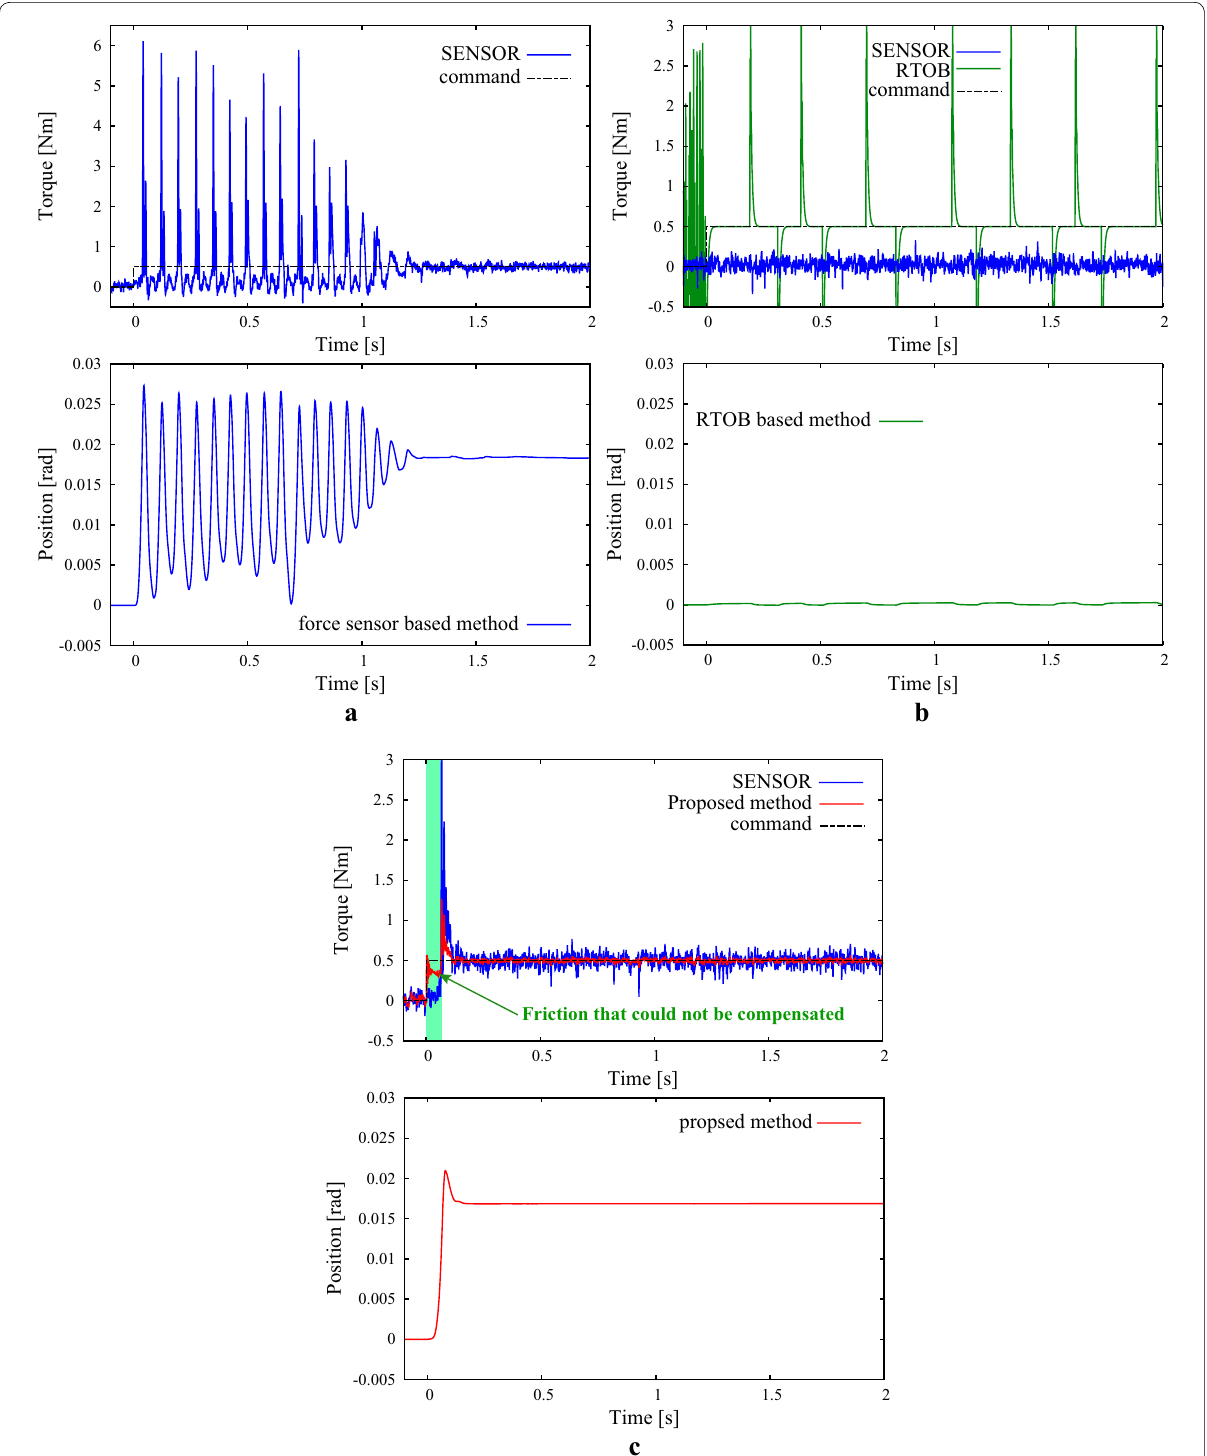
Fig. 16 Force and position responses of the force control systems. a Force control based on force sensor. b Force control based on RTOB. c Force control based on the proposed